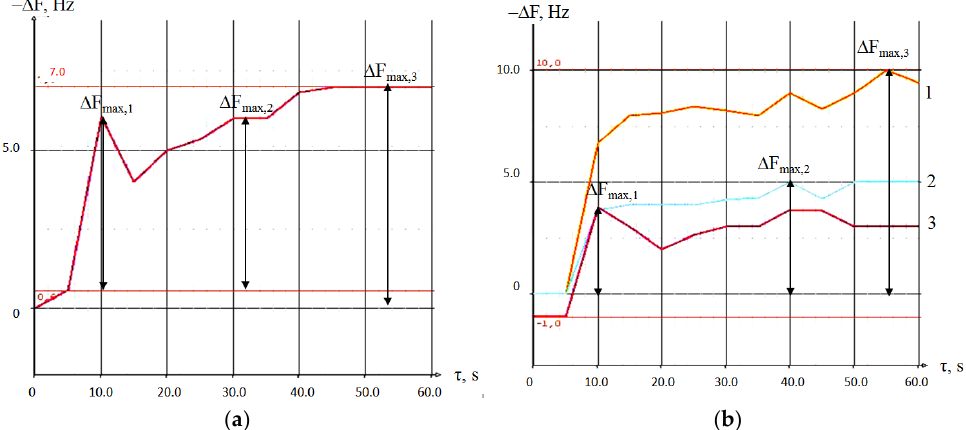
Figure 4. Chronofrequency grams of 3-methylbutanoic acid vapor sorption by a sensor with a polycomposite coating 18-crown-6/PEGA/PDEGS ( a ) and an array of sensors ( b ) with films 18-crown-6 (1), PEGA (2), PDEGS (3).